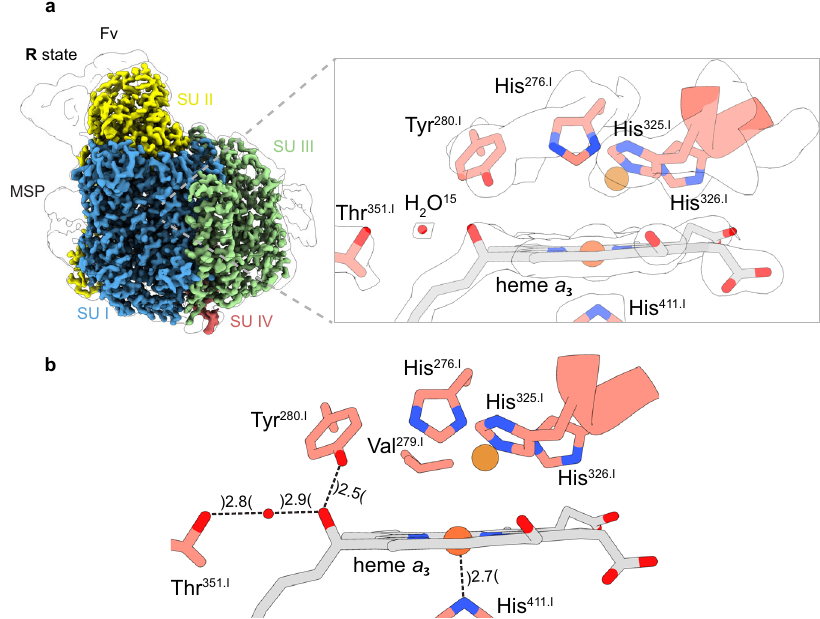
Fig. 5 Cryo-EM density map (R-state) and modelled structure of the binuclear site in C c O. a Structural overview of the binuclear site in the R -state. Densities located between the iron (orange) and copper atom (brown) were not observed, indicating a fully reduced binuclear site. b Measured distances (Å) for the modelled molecules at the active site. The corresponding density map is illustrated as a white surface. The illustrated map densities are fi ltered to equal contour levels of